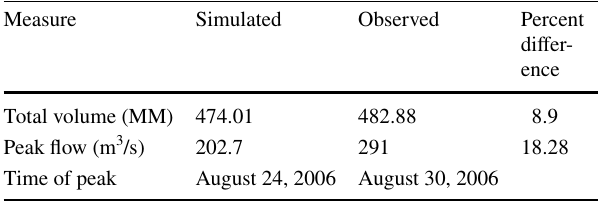
Table 12 Calibration for SCS CN loss method result